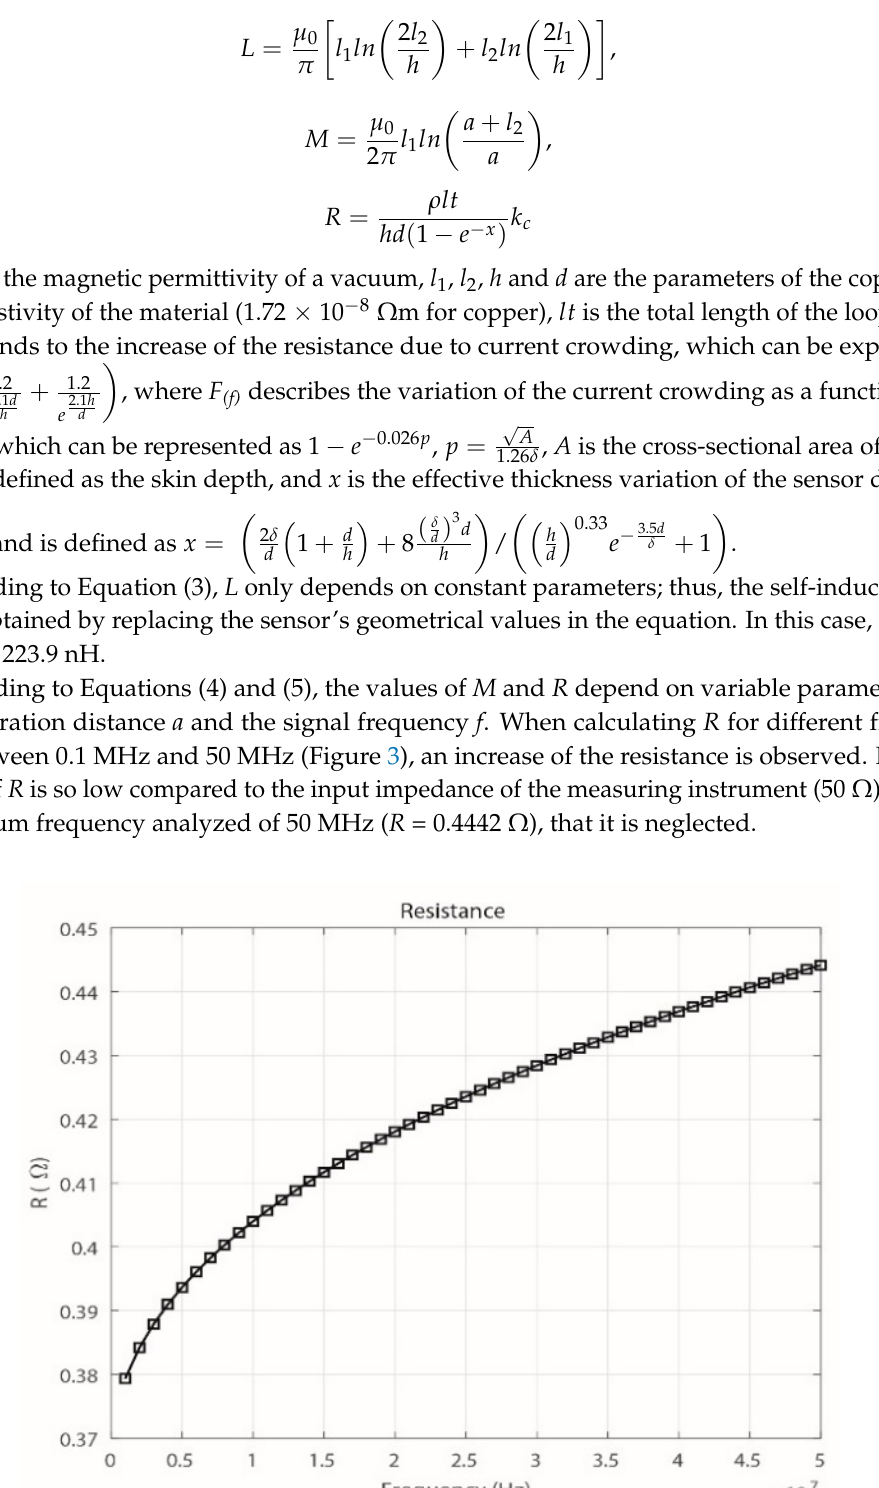
Figure 4. Theoretical behavior of the mutual inductance with increasing a . 3.2. Calculation of the Electrical Parameters Using the Finite Element Method The calculation of the electrical parameters from the finite element modelling was performed using the Finite Element Method Magnetics (FEMM) software. In this software, a magnetic model of the sensor was implemented through a two-dimensional configuration of each of the conducting sections, including the primary conductor (both on copper) (Figure 5).